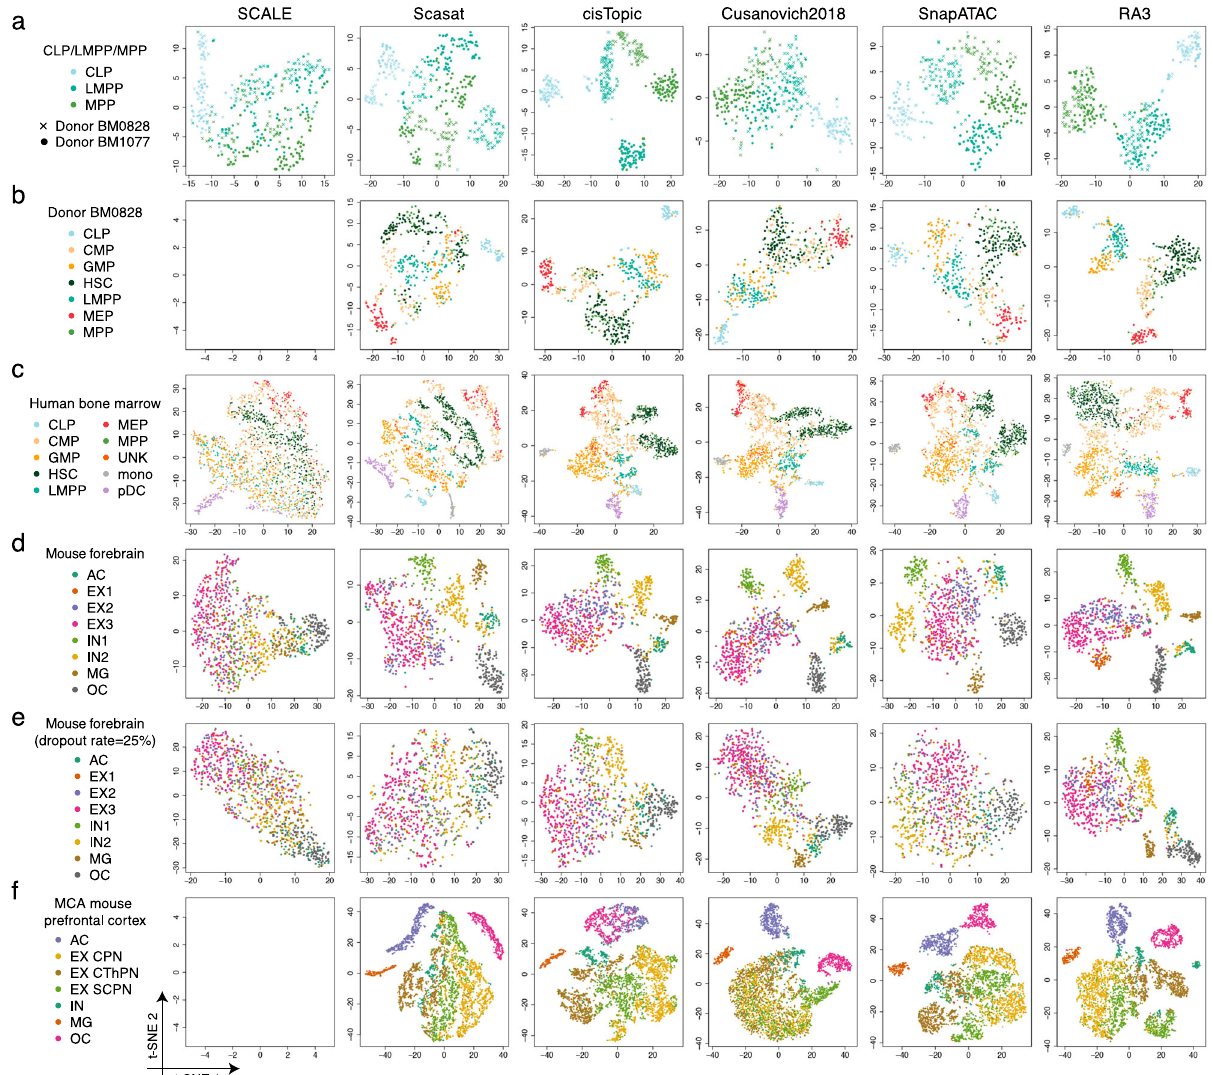
Fig. 3 Evaluation of the visualization of scCAS data. a The dataset of CLP/LMPP/MPP cells. b The dataset of donor BM0828. c The human bone marrow dataset. d The mouse forebrain dataset (half). e The mouse forebrain dataset (half) with 25% dropout rate. f The dataset of mouse prefrontal cortex. For all the datasets, we obtained the latent features from SCALE, Scasat, cisTopic, Cusanovich2018, SnapATAC, and RA3, and then implemented t-SNE